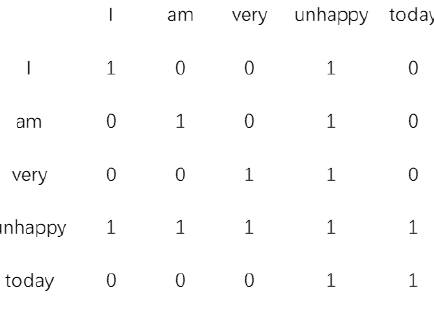
Figure 5. The adjacency matrix of a